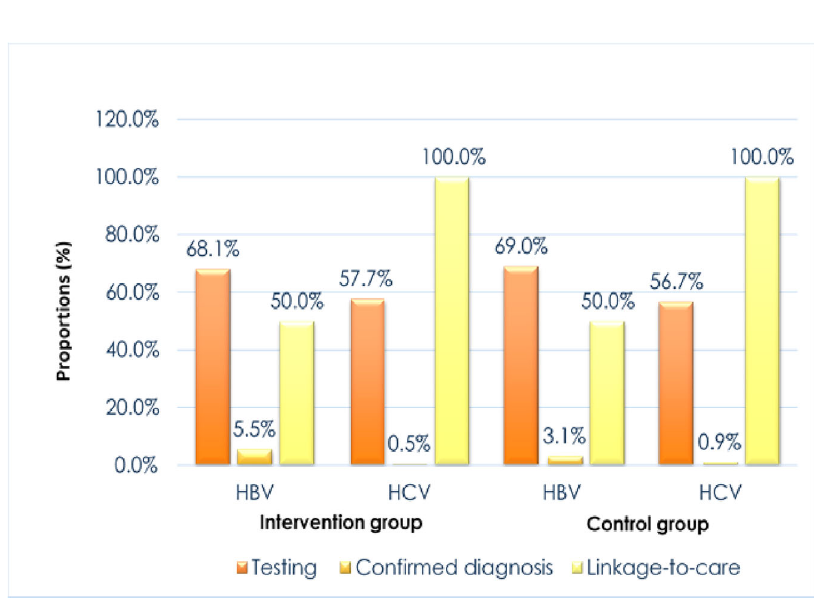
Fig. 2 HBV and HCV testing uptake and linkage-to-care rates among primary care patients in urban China. Proportions of study participants in the intervention group vs. control group who accessed HBV and HCV testing and seeked treatment care post-testing at the family medicine and primary care clinic within the 4-weeks study